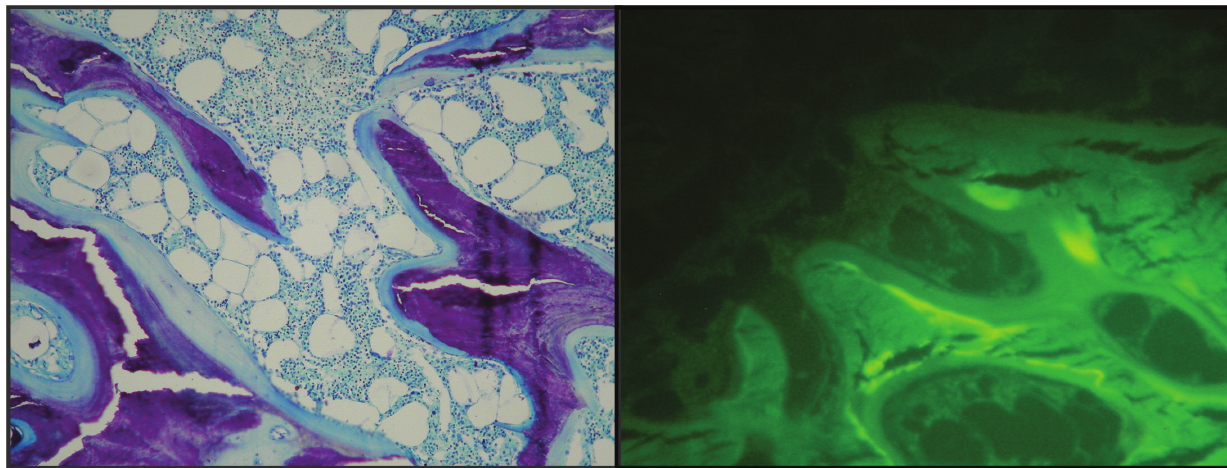
Figure 2 - Biopsy of patient - bone trabecula; bone medulla; osteoid matrix. Absence of double tetracycline